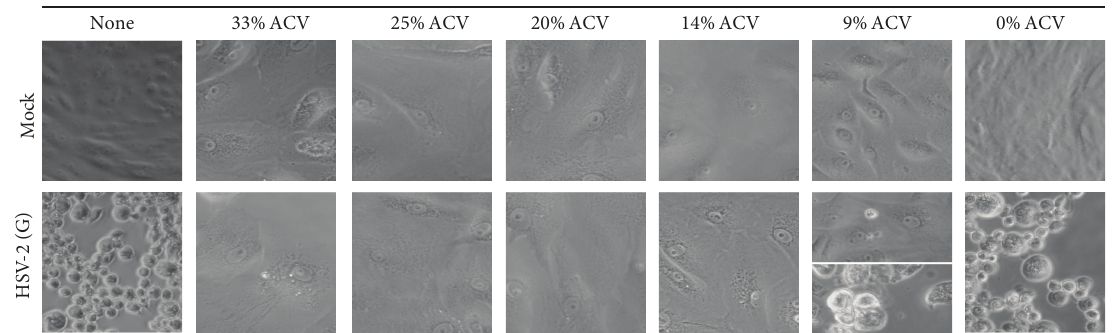
Figure 3: Comparison of antiviral activity of MED-4750 polymers impregnated with varying quantities of ACV. Vero cells were grown to near-confluence in 24-well culture plates. Implants were prepared by mixing MED-4750 component A, MED-4750 component B, and ACV in varying ratios, and one implant was placed in each well. Two days later, either medium alone (“Mock”) or HSV-2 (G) (95pfu) was added to the indicated wells. Wells marked “None” received no implant; the rest received implant formulated with the indicated percentage of acyclovir. Wells were photographed 3 days after infection. In the split panel of HSV-2 (G)-infected cells incubated with an implant containing 9% ACV; the top and bottom panels were photographed 3 and 5 days after infection, respectively.